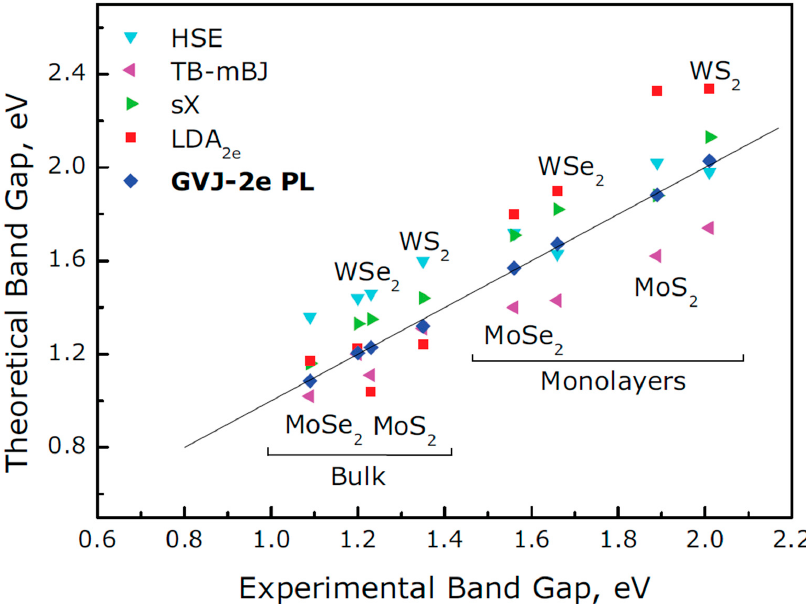
Figure 4. Theoretical and experimental band gap energies of MoS 2 , WSe 2 , MoSe 2 , and WS 2 . The bulk materials present lower energies, and the band gap is indirect in all cases. Reprinted (adapted) with permission from Ref. [88]. Copyright (2017) John Wiley and Sons. Table 2. Outline of the experimental and theoretical bandgaps of different 2D materials. D stands for direct and I stands for indirect band gap.